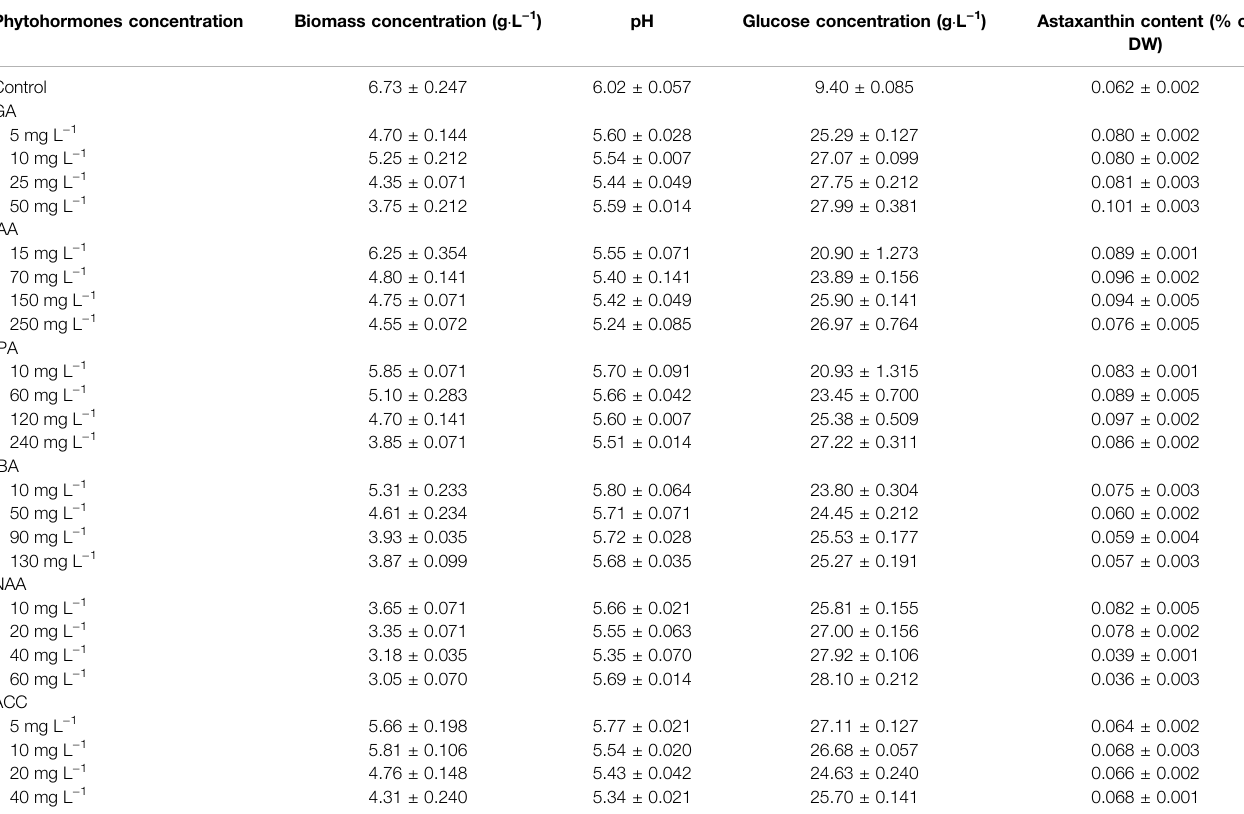
TABLE 1 | C. zo fi ngiensis biomass concentration (g · L − 1 ), pH, glucose concentration (g · L − 1 ), and astaxanthin content (% of DW) at the termination of each experiment. Phytohormones